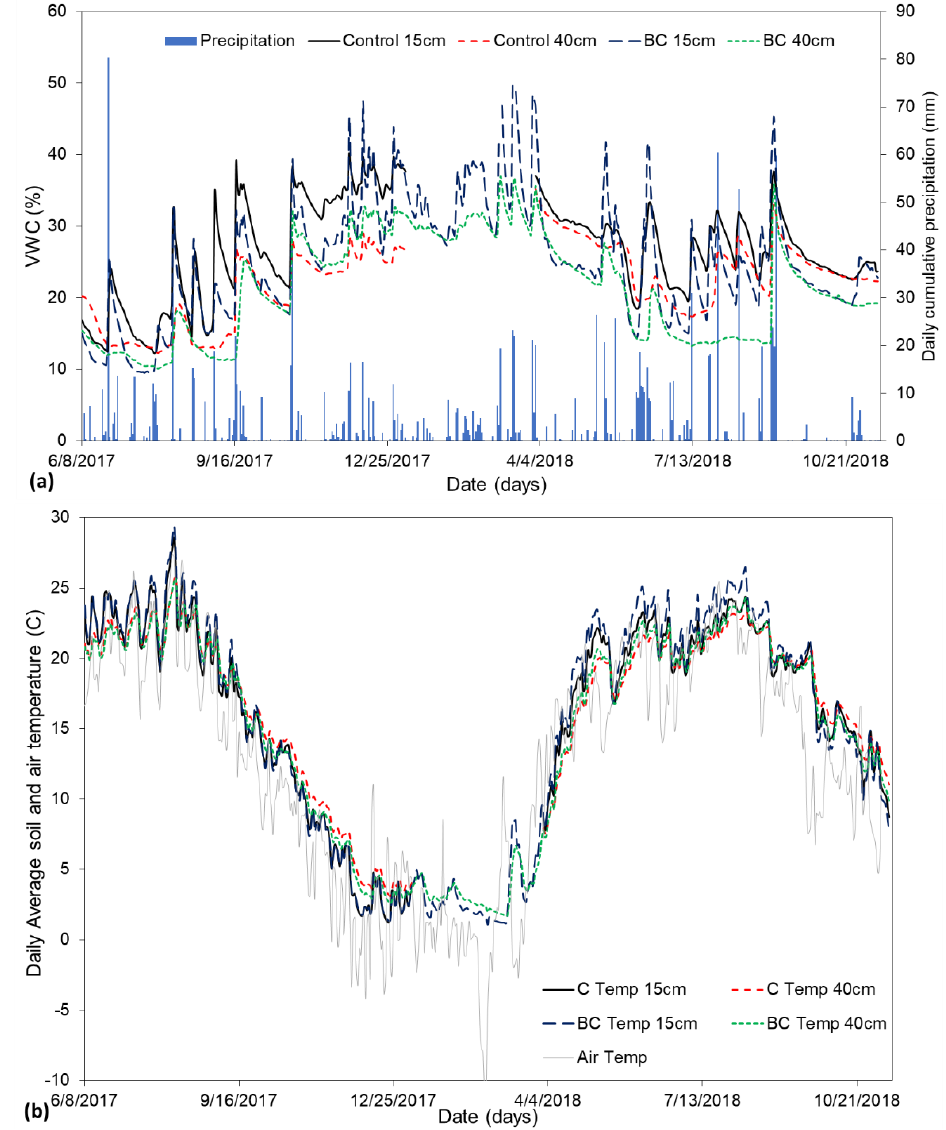
Figure 4. Changes in ( a ) soil volumetric water content (VWC) and ( b ) soil temperature as influenced by biochar (BC) addition.